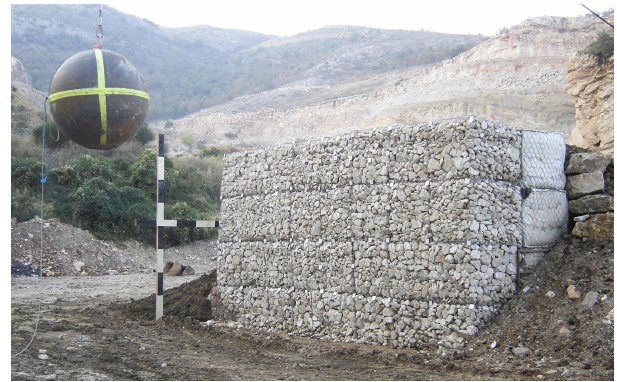
Figure 1. View of the tested embankment, showing the sandwich wall leaned against the levee and the hanging